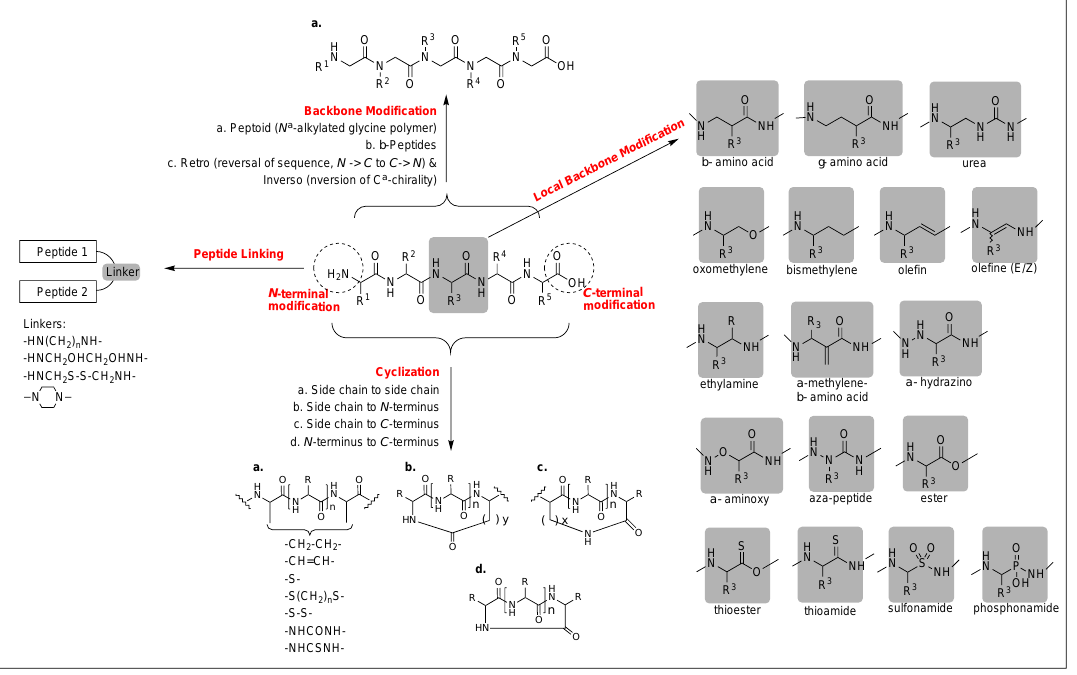
Figure 6. Various tools for peptidomimetics. β -peptides, poly β -amino acids, possess greater structural diversity and high resis- tance to the enzymatic degradation due to the additional carbon atom in each amino acid residue, and their biological properties differ from those of parent peptides. Substitution of each amino acid with respective β -amino acids in Leu-ENK, DER, and DLT resulted in a loss of the affinities at MOR and DOR [217]. Other backbone modifications are retro (reversal of backbone), inverso (inversion of chirality of amino acid), and retro-inverso modifications applied to opioid peptides as a tool for structural alteration to improve metabolic stability [218]. These modifications of opioid peptides are not considered to be promising due to the interruption of the spatial disposition of key side chains, despite a few successful cases [218,219]. Overall, studies on backbone modifications of opioid peptides indicated that this approach is not efficient due to resulting structural